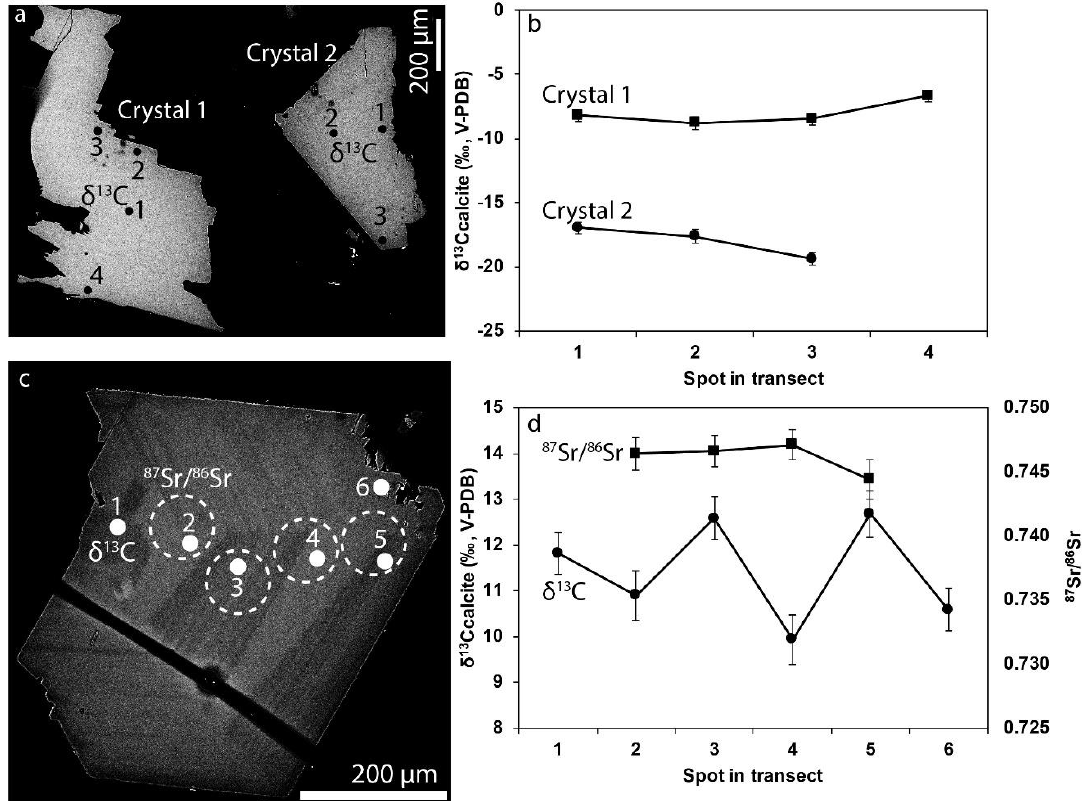
Figure 2. Transects of δ 13 C and 87 Sr / 86 Sr values from microanalyses within polished calcite crystals mounted in epoxy. ( a ) Back-scattered electron (BSE) image of two crystals from sample 181 m with δ 13 C for each crystal transect shown in ( b ). ( c ) BSE image of a crystal from sample 185 m with δ 13 C and 87 Sr/ 86 Sr values shown in ( d ). The crystal in ( c ) is more heterogeneous in δ 13 C and BSE intensity than crystals in ( a ), due to higher degree of growth zonation in the former. Note the larger spot size of the Sr isotope analysis (80 µm, spot craters shown in Figure 4) compared to C isotope analysis (10 µm). Error bars represent 2σ.